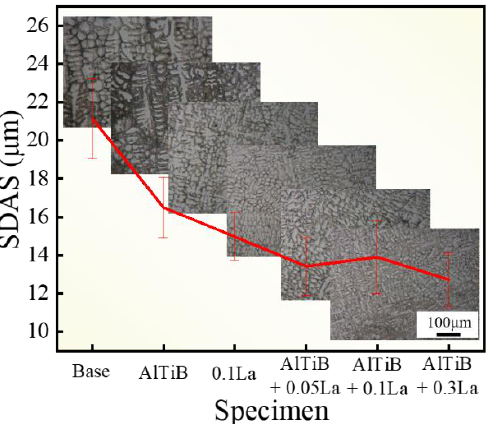
Figure 3. Metallographic morphology and SDAS statistics of 6 groups of alloys after corrosion.